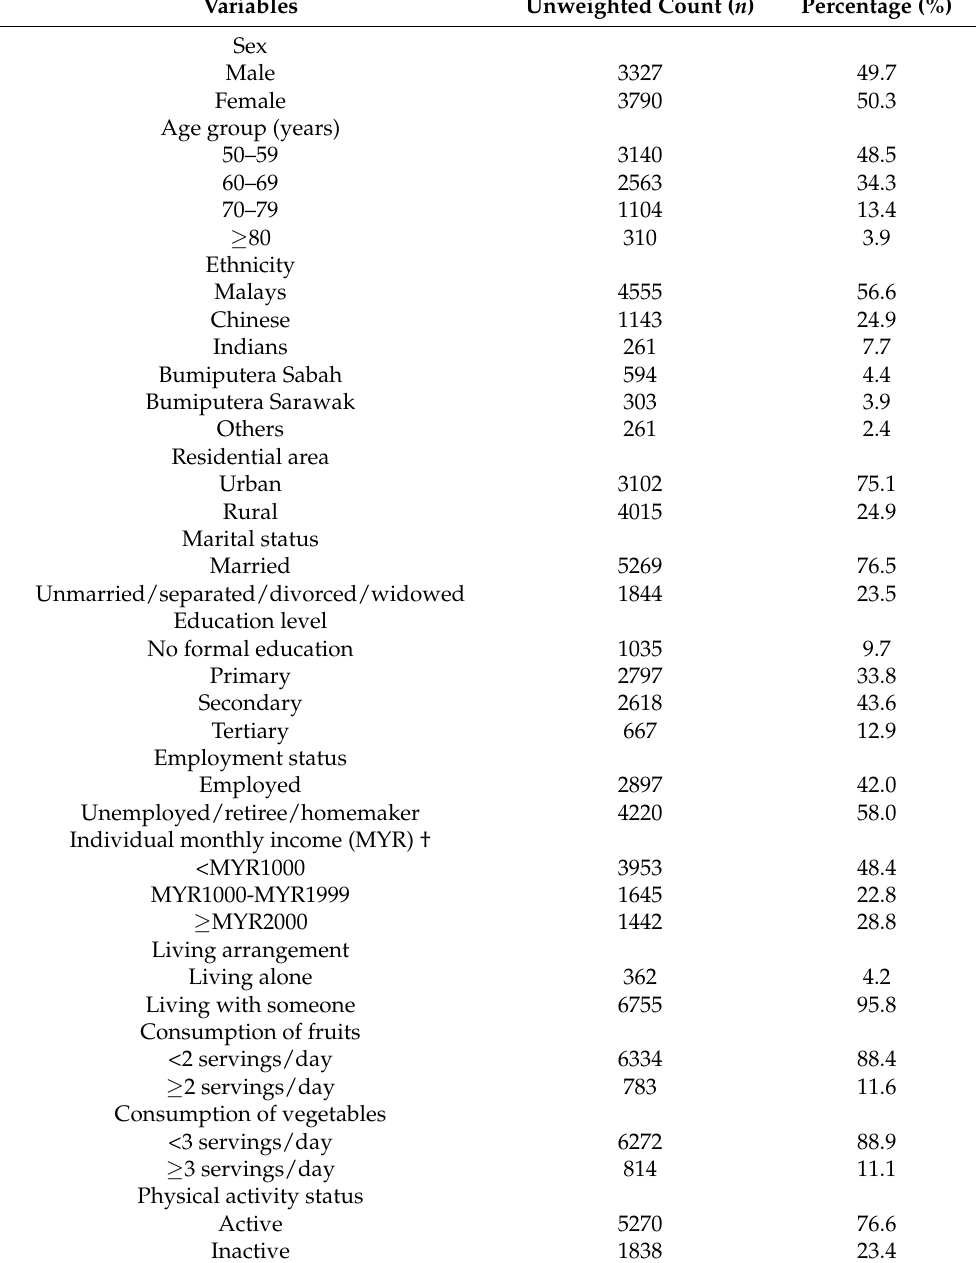
Table 1. Descriptive characteristics of the study participants ( n = 7117), NHMS